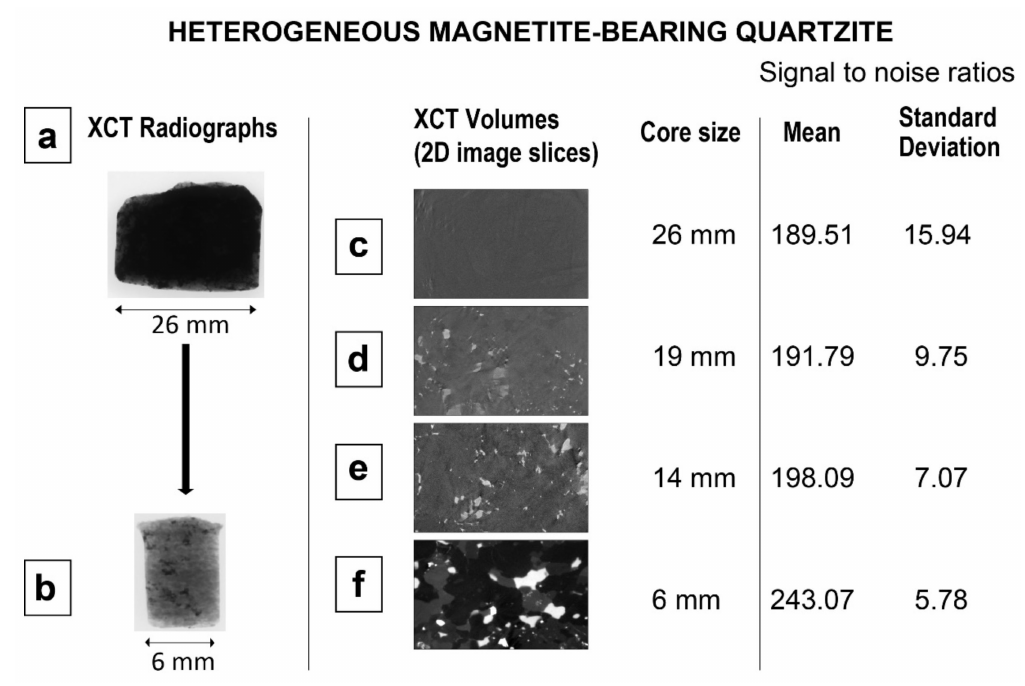
Figure 5. Radiographs of 26 mm against the 6 mm core of the magnetite-bearing quartzite ( a , b ). Their associated gray level XCT 2D images are given ( c , f ). XCT 2D image slices for 19 and 14 mm core sizes ( d , e ). Calculated signal to noise ratios (mean and standard deviation) are also